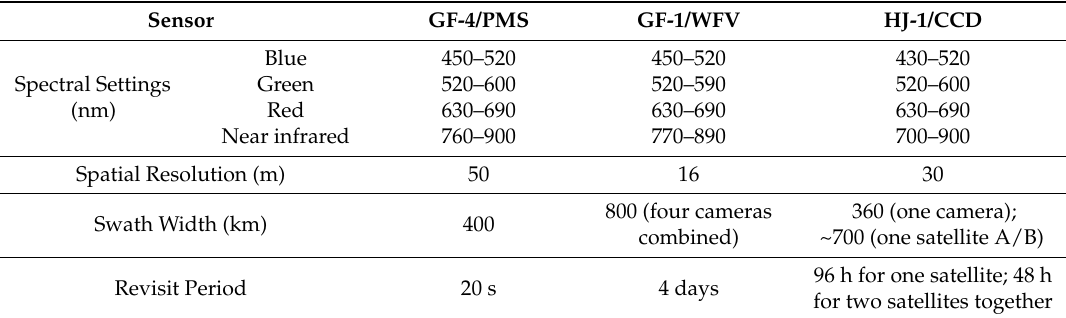
Table 1. Primary characteristics of GaoFen-4 (GF-4)/panchromatic and multispectral sensor (PMS), GF-1/wide field of view sensor (WFV), and HuanJing-1 (HJ-1)/charge-coupled device (CCD) in multispectral